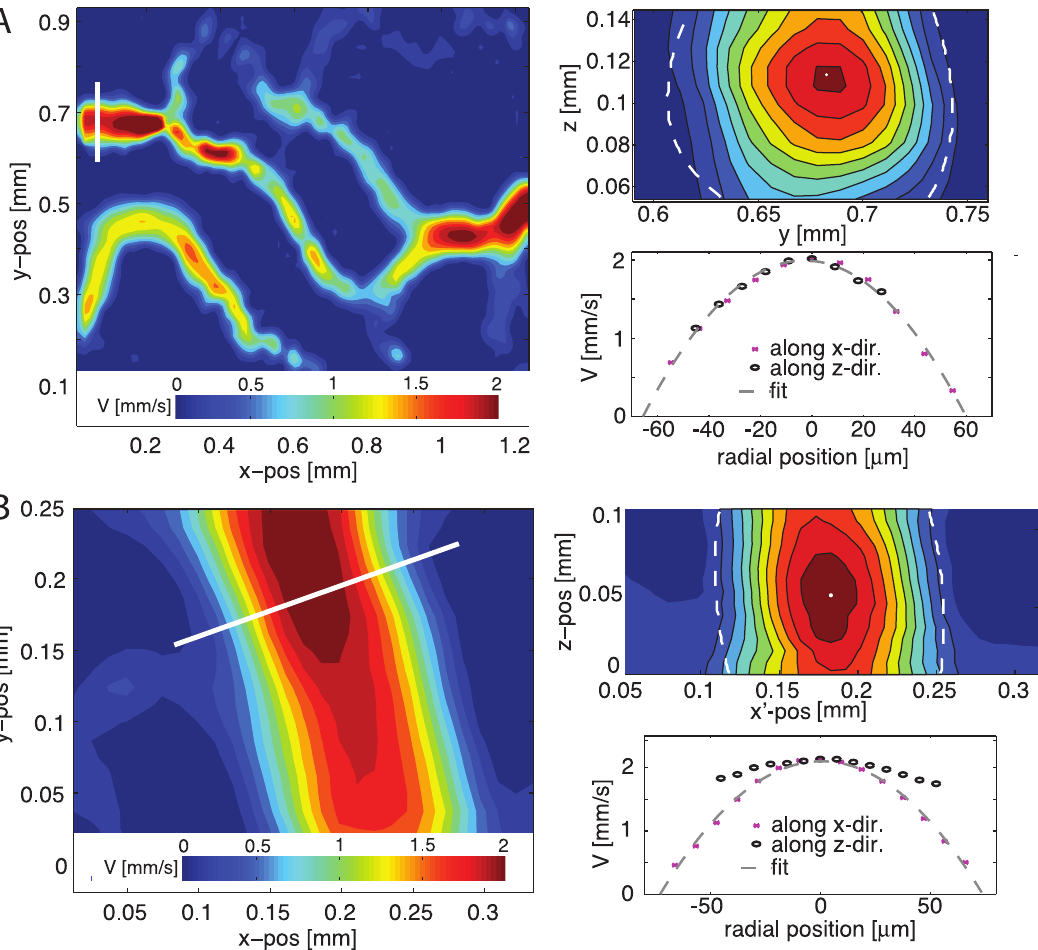
Figure 10. Effect of tracer choice on 3D reconstructions. (A): Three-dimensional reconstruction using tracers. Left : single measurement result of the velocity magnitude. Top right : cross-section taken along the white line in the left-hand figure. Bottom right : in-plane and out-of-plane velocity profile. (B): Three-dimensional reconstruction using RBCs. Left : single measurement result of the velocity magnitude. Top right : cross-section taken along the white line in the left-hand figure; x 0 is the axis in the coordinate system aligned with the profile. Bottom right : in-plane and out-of-plane velocity profile. M ~ 25 | . Note the apparent stretching along the z -axis, which is discussed in the section ‘Implications for 3D reconstructions’ .